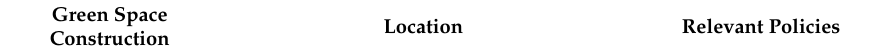
Table 1. Green planning policies.